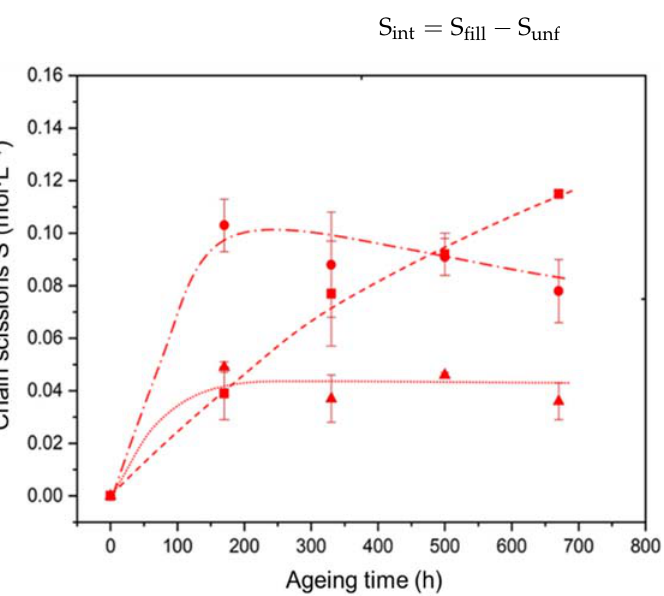
Figure 12. Comparison of the changes in the concentration of chain scissions outside ( □ ) and inside the interfacial region for the two composite materials with 25 phr ( ) and 50 phr ( ) of ATH, during their radio ‐ thermal exposure in air under 400 Gy ∙ h − 1 at 21 °C.